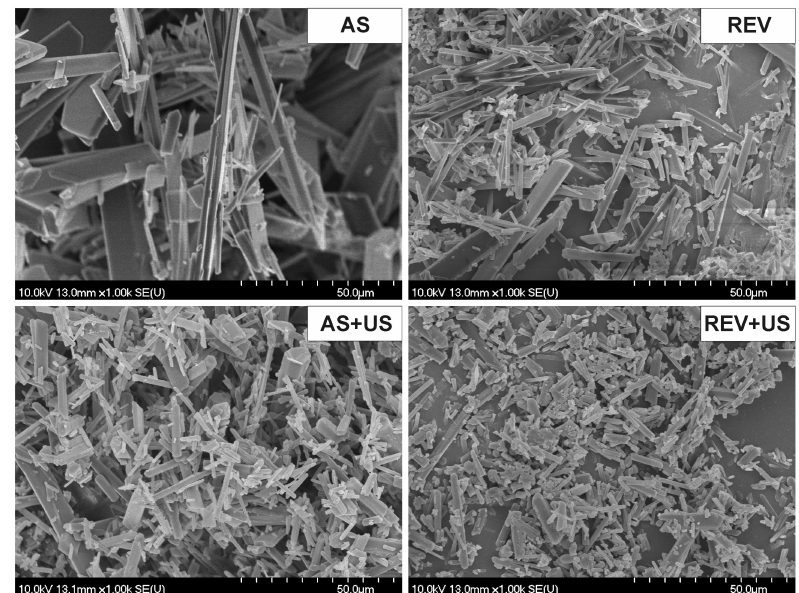
Figure 4. SEM images of the conventional crystallization